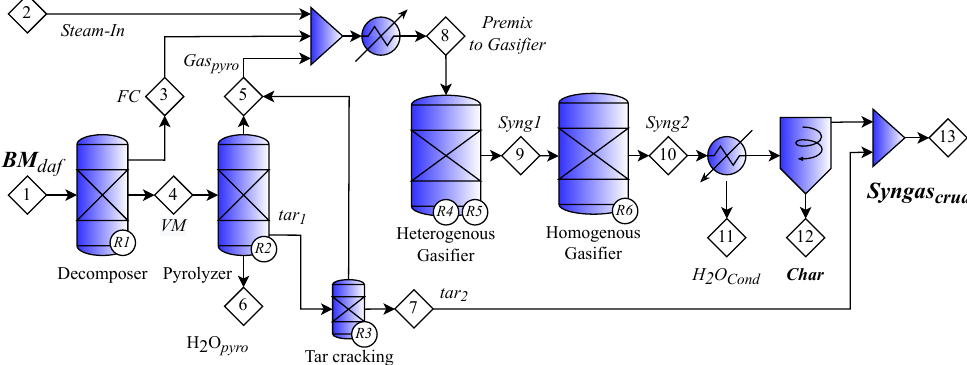
Figure 2. Flowsheet topology for the steam gasification of biomass in a downdraft reactor. The flow diagram definitions for models StoicM and KinetM